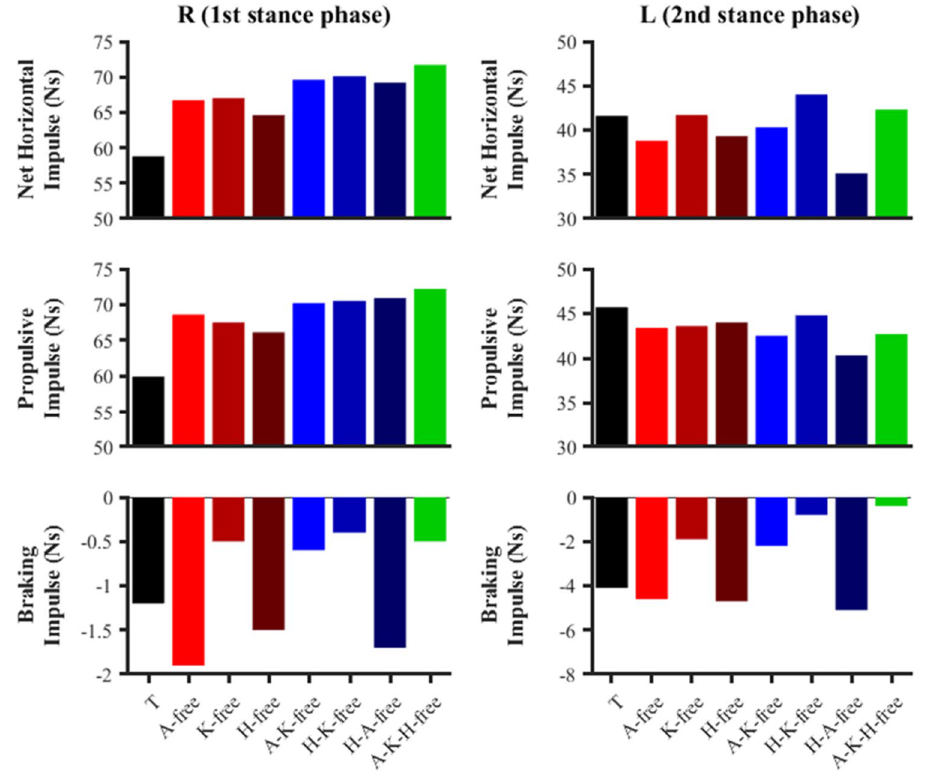
Figure 4. Right (R) and left (L) stance phase anterior–posterior impulses for the data-tracking (T) and predictive simulations (A-free, K-free, H-free, A-K-free, H-K-free, H-A-free,